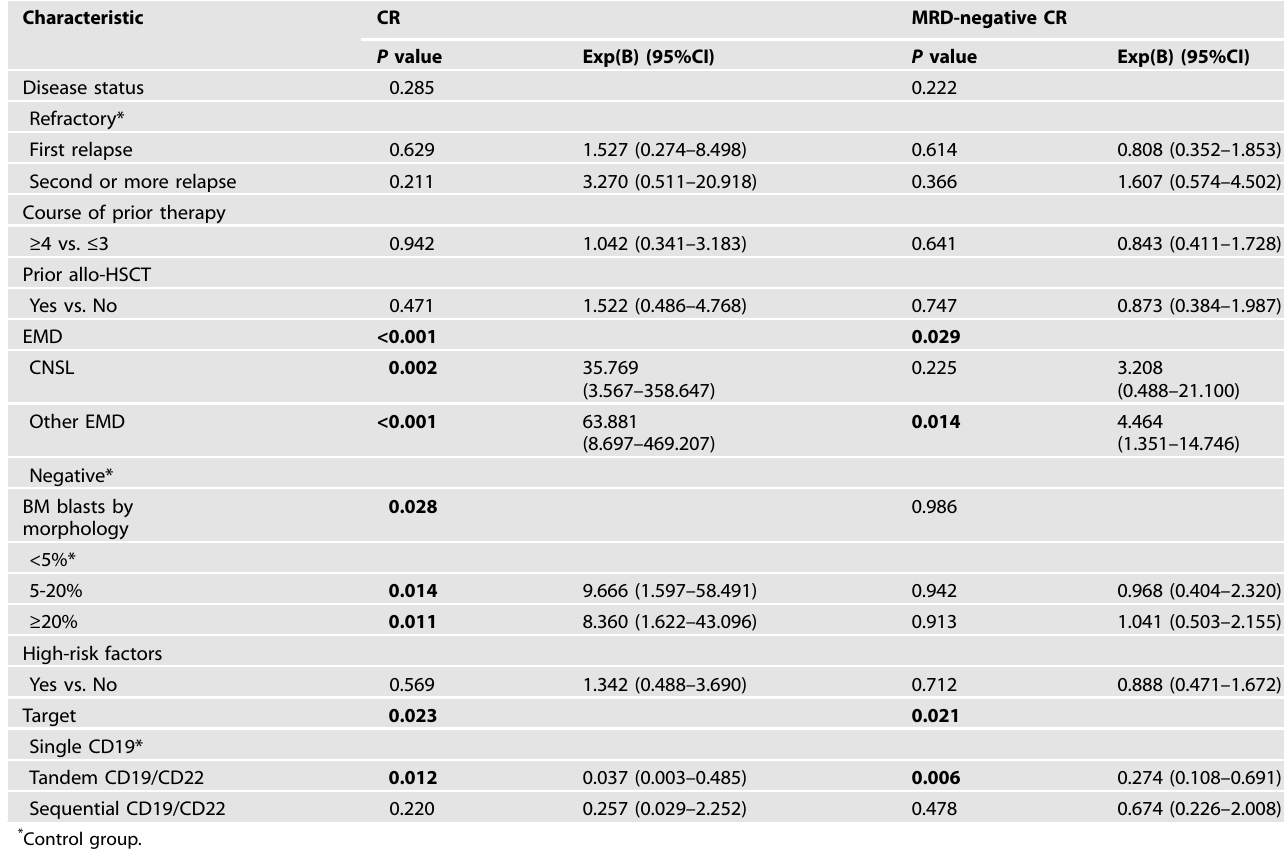
Table 2. Multivariate analysis for treatment response.